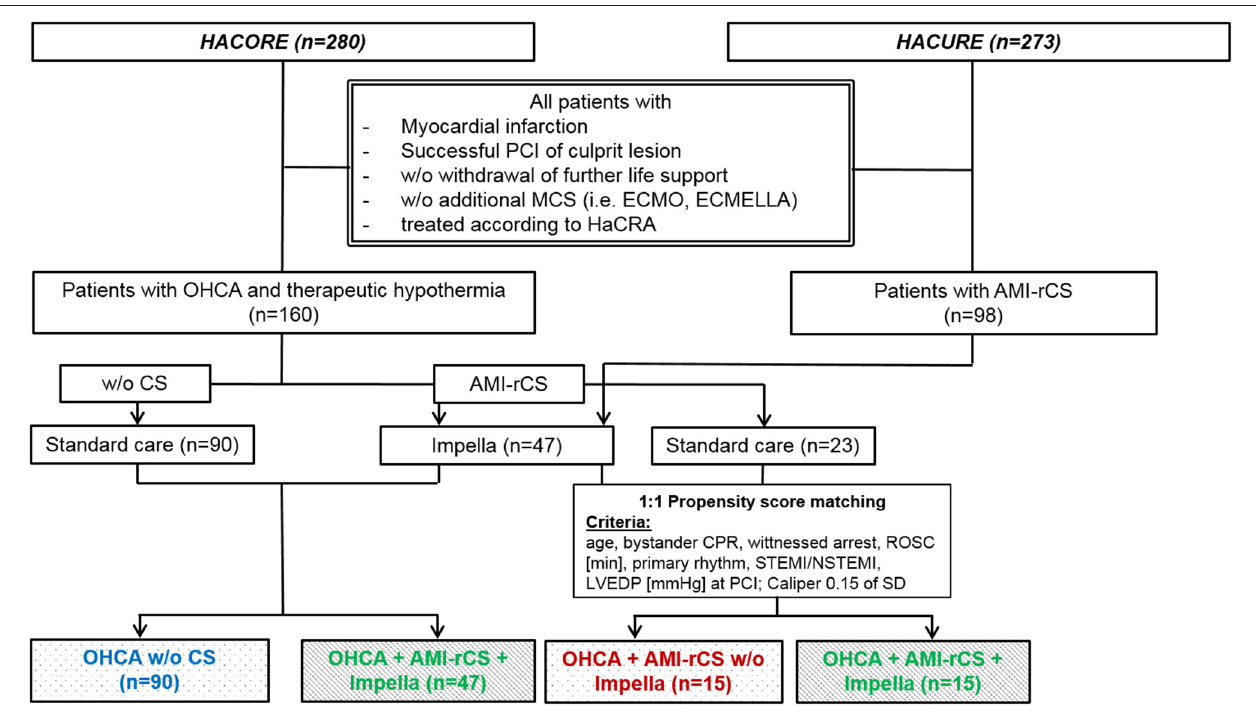
FIGURE 1 | Study enrolment. AMI, acute myocardial infarction; CPR, cardio-pulmonary resuscitation; CS, cardiogenic shock; ECMELLA, circulatory support by a combination of Impella and ECMO; ECMO, extracorporeal membrane oxygenation; HACORE, Hannover Cooling Registry; HaCRA, Hannover Cardiac Resuscitation Algorithm; HACURE, Hannover Cardiac Unloading Registry; MCS, mechanical circulatory support; NSTEMI, non-ST elevation myocardial infarction; PCI, percutaneous intervention; OHCA, out-of-hospital cardiac arrest; rCS, refractory cardiogenic shock; ROSC, return of spontaneous circulation; SD, standard deviation; STEMI, ST elevation myocardial infarction; w/o,